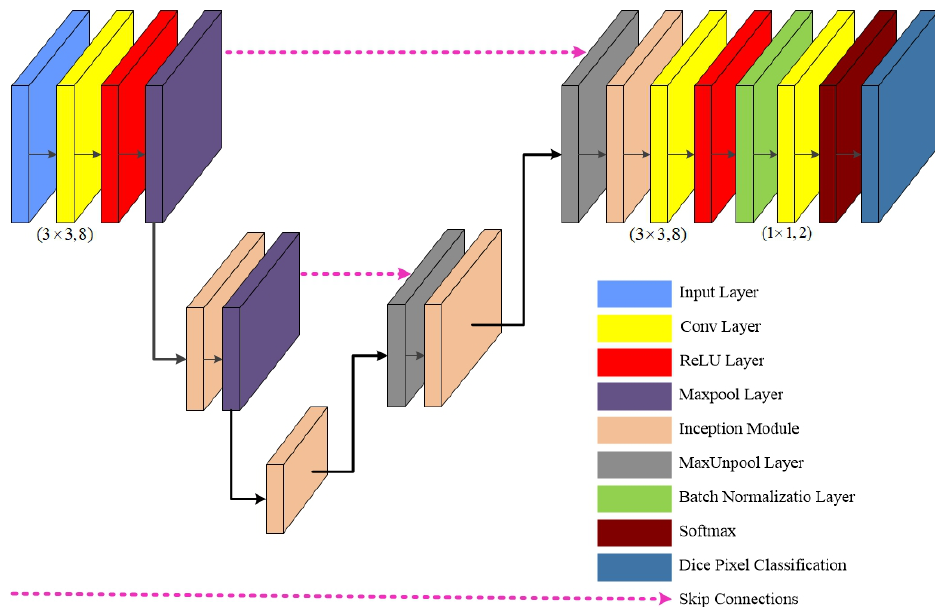
Figure 1. Block diagram of the proposed